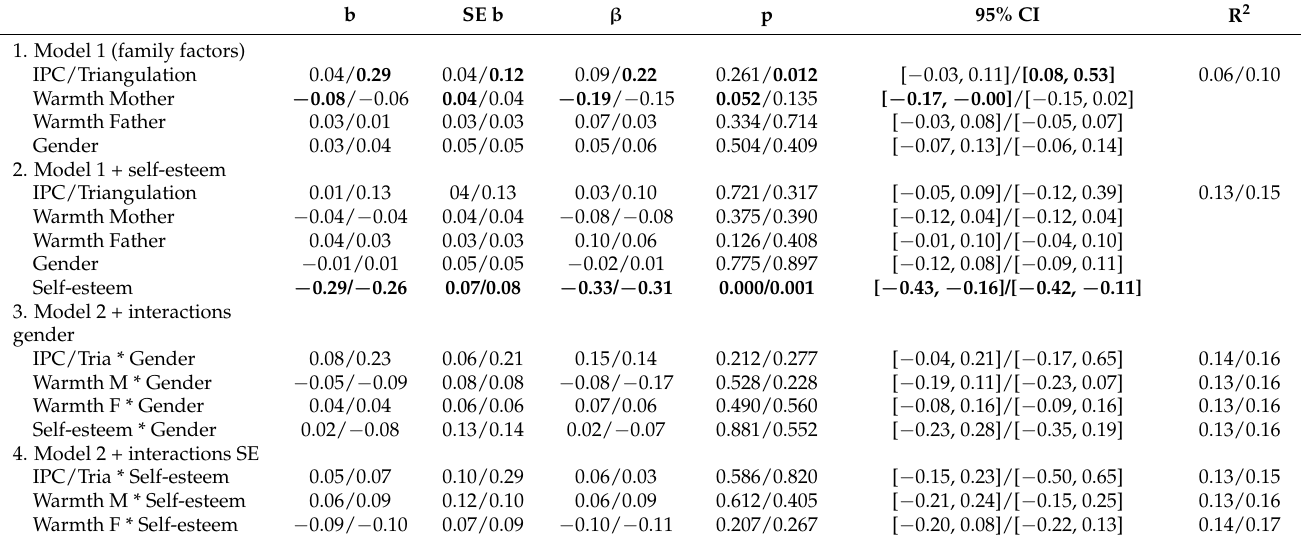
Table 3. Regression estimates for PIU: interparental conflict and triangulation